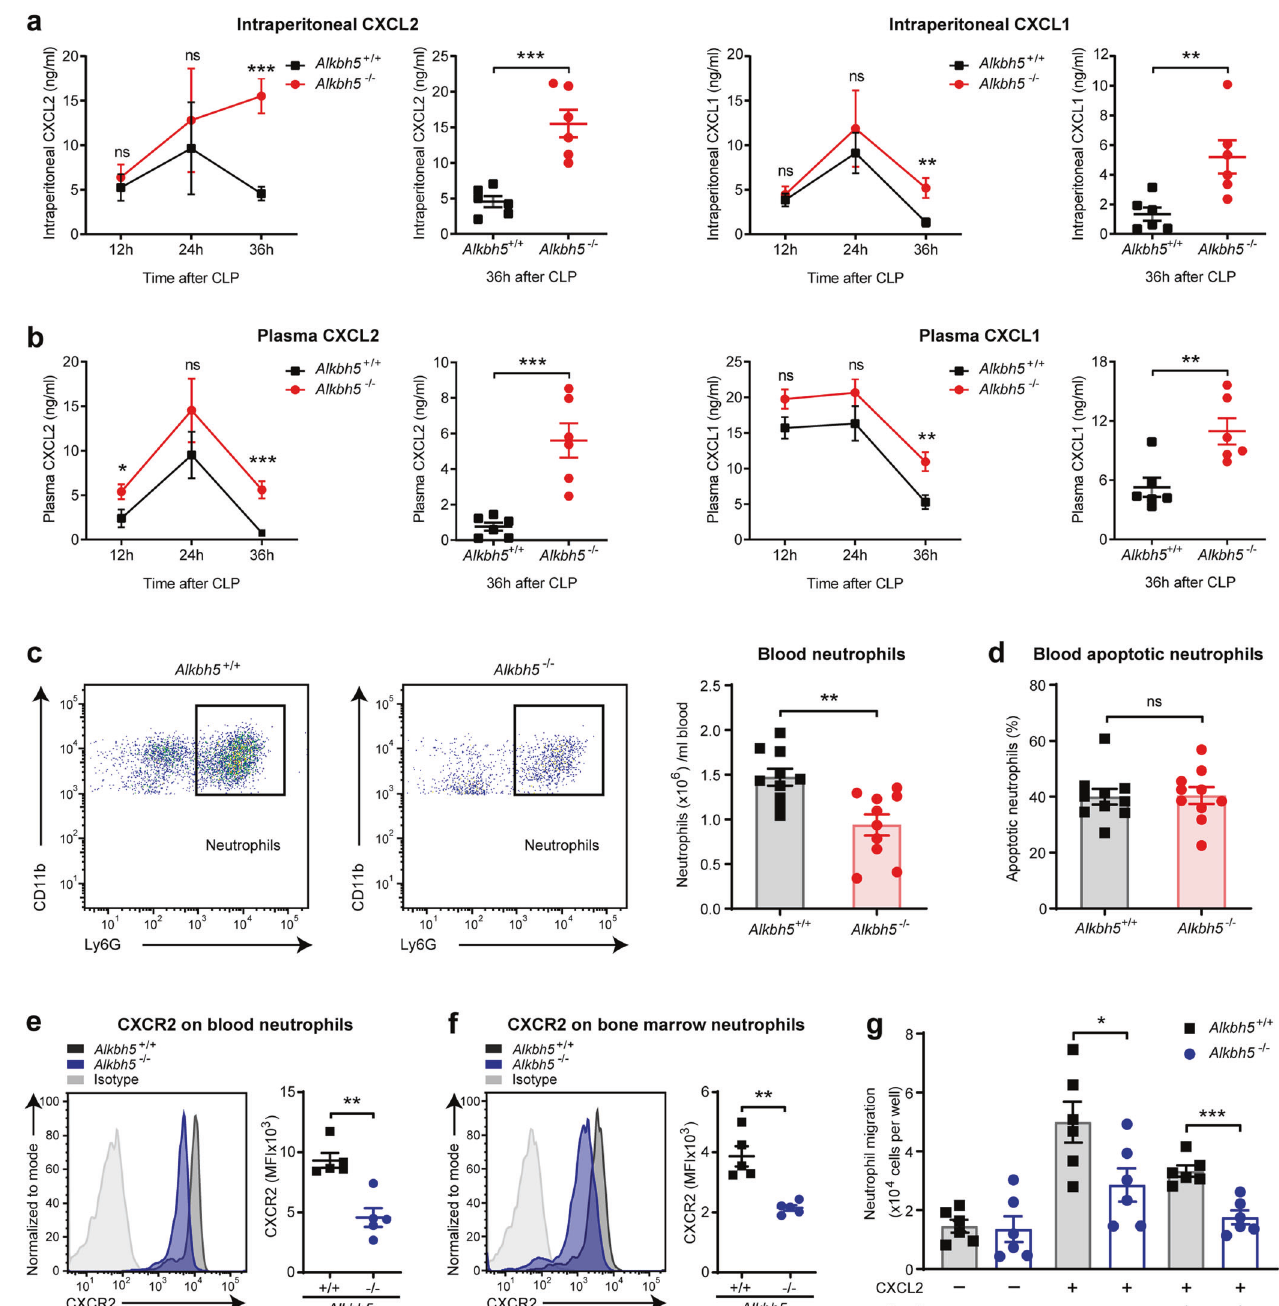
Fig. 3 De fi ciency of ALKBH5 reduces the migratory ability of neutrophils toward chemokines. a , b ELISA of CXCL2 and CXCL1 concentrations in the peritoneal lavage fl uid ( a ) and plasma ( b ) of Alkbh5 -de fi cient mice and WT littermates at indicated times after mild CLP ( n = 6). c FACS analysis of neutrophils in the blood of Alkbh5 -de fi cient mice and WT littermates 36 h after mild CLP ( n = 10). d FACS analysis of apoptotic neutrophils in the blood of mice as in ( c ) ( n = 10). e , f FACS analysis of protein expression of CXCR2 on cell-surface of neutrophils from blood ( e ) or bone marrow ( f ) of Alkbh5 -de fi cient mice and WT littermates 24 h after mild CLP ( n = 5). MFI, mean fl uorescence intensity. g Transwell migration assay of neutrophil migration toward CXCL2. Neutrophils that puri fi ed from the bone marrow of Alkbh5 -de fi cient mice and WT littermates at steady state were infected with or without E.coli and then treated with CXCL2 (30 ng/ml) for 2 h as indicated, then migration assay was determined ( n = 6). All data are mean ± SEM of biologically independent samples. Data are representative of 5 or 10 independent experiments with similar results [( c ) and ( e , f )]. * P < 0.05; ** P < 0.01; *** P < 0.001; ns, not signi fi cant. Two-tailed unpaired Student ’ s t test ( a – g ) ALKBH5 enhances CXCR2 but suppresses migration-inhibitory neutrophils (Supplementary Fig. 7b, c). Therefore, ALKBH5 drives a molecule expression in neutrophils migration-promoting transcriptional landscape of neutrophils to In order to identify the downstream targets of ALKBH5 involved in enable their migration into the site of infection for bacterial neutrophil migration, we then con fi rmed the ALKBH5-driven eradication.